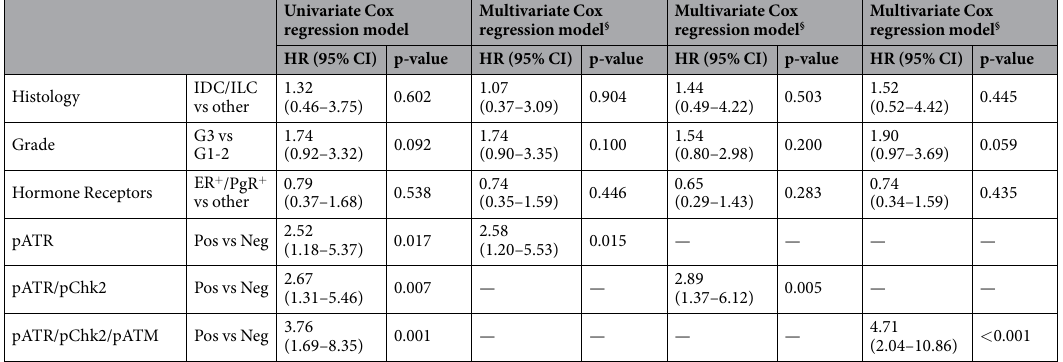
Table 3. Univariate and multivariate Cox regression models for overall survival (N = 112). § Adjusted for : Histology, Grade, Hormone Receptor Status.